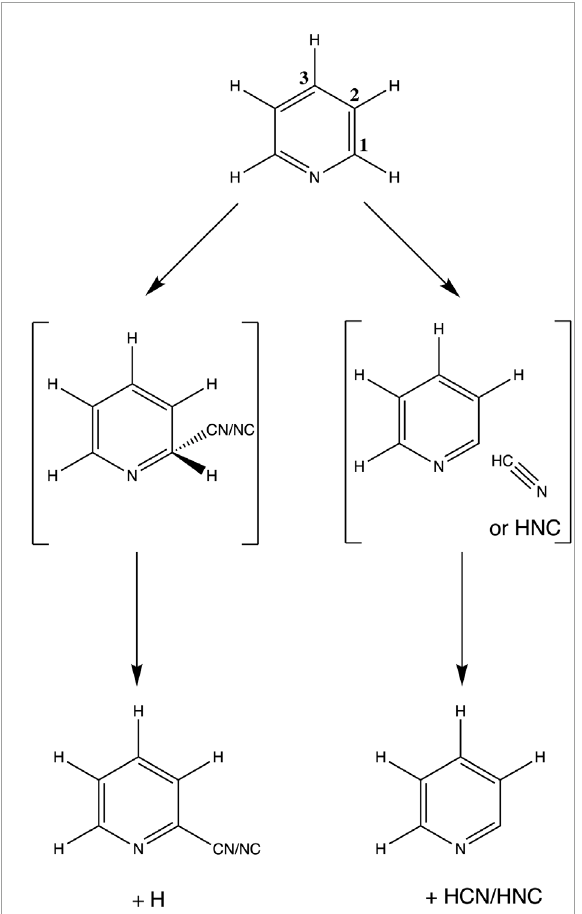
FIGURE 1 Scheme of the reactions considered in this work, as well as the different equivalent carbon positions for the reactions to occur. This example depicts reactions in